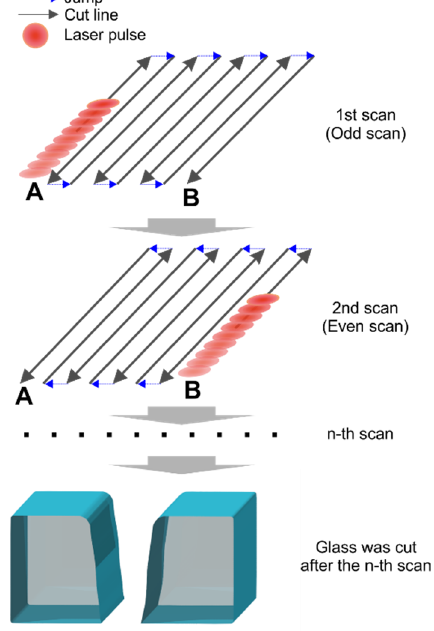
Figure 1. Scan geometry used to cut glass. Arrows represent the laser beam scanning direction for the odd and even scans. For the odd scan, the laser beam scanning direction was from position A to B. For the even scan, the laser beam direction was the opposite (laser beam was scanned from position B to A). Scans were repeated multiple times until the glass was cut through.